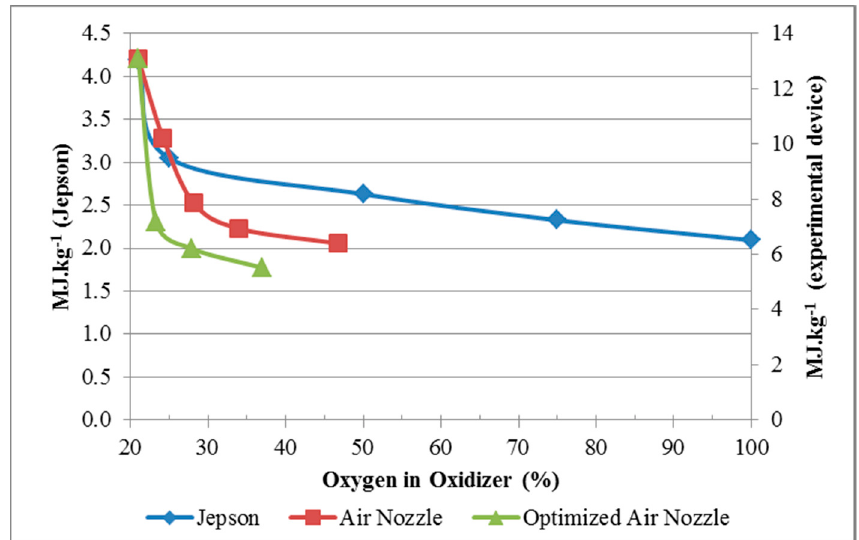
Figure 6. Comparison of energy consumption per 1 kg of charge depending on the oxidizer oxygen concentration (Adapted from [9], calculated from the experimental measurement).